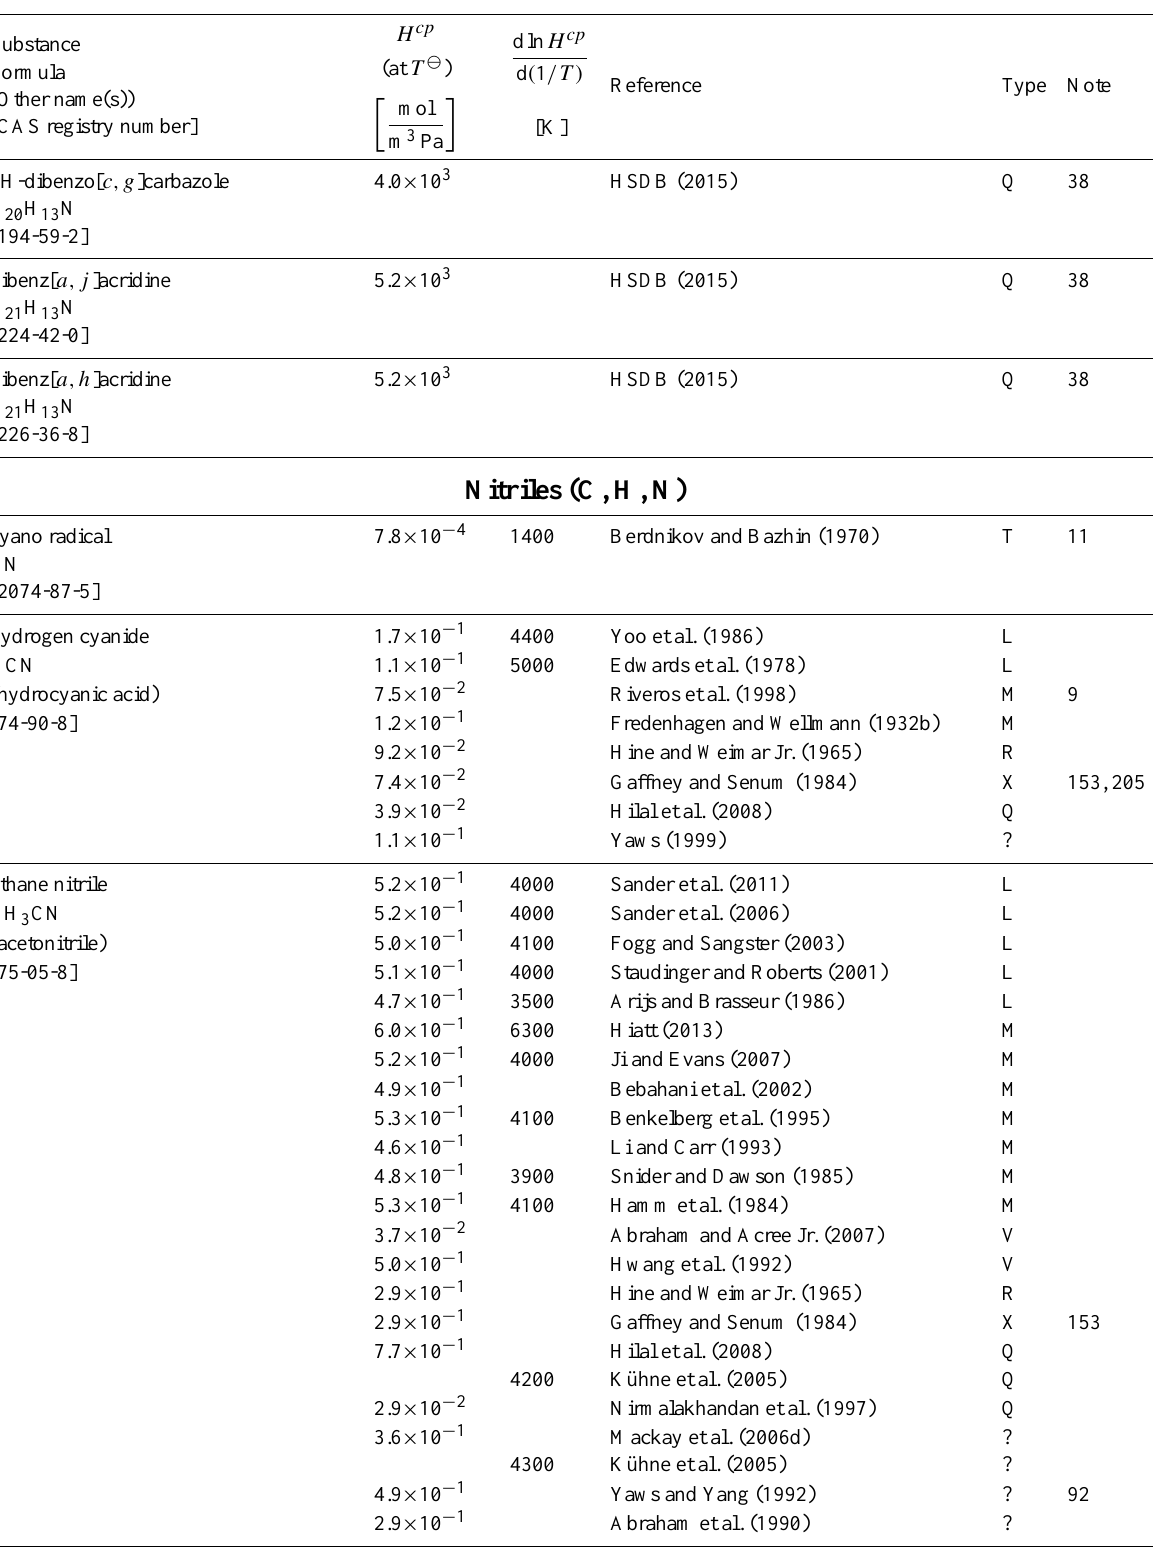
Table 6: Henry’s law constants for water as solvent